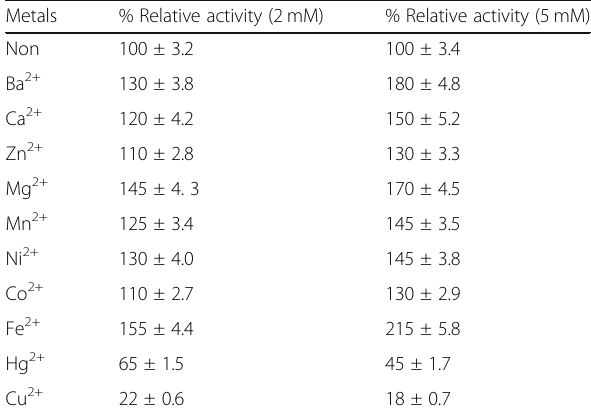
Table 3 Effect of metal ion concentration on ginger